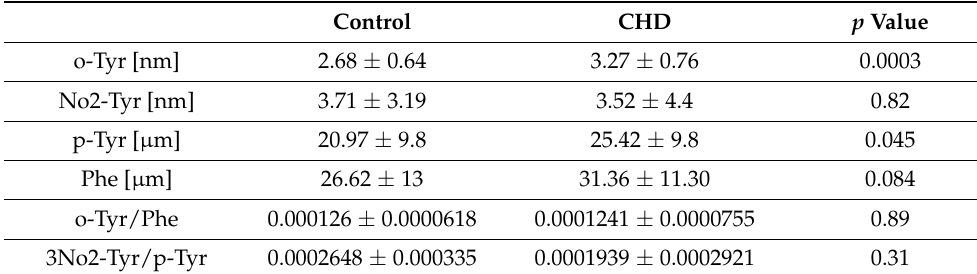
Table 3. Oxidative stress biomarkers in amniotic fluid.